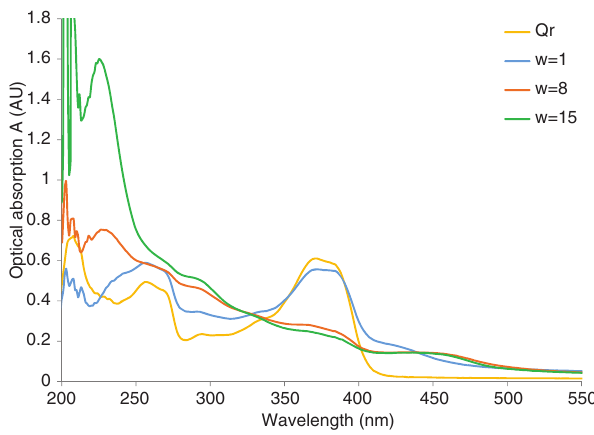
Figure 6 Absorption spectra of Rh Chem NPs in reversed micellar solutions at different ω : ω corresponds to the spectrum of the solution from which the nano- particles are synthesized by adding metal salt to it.